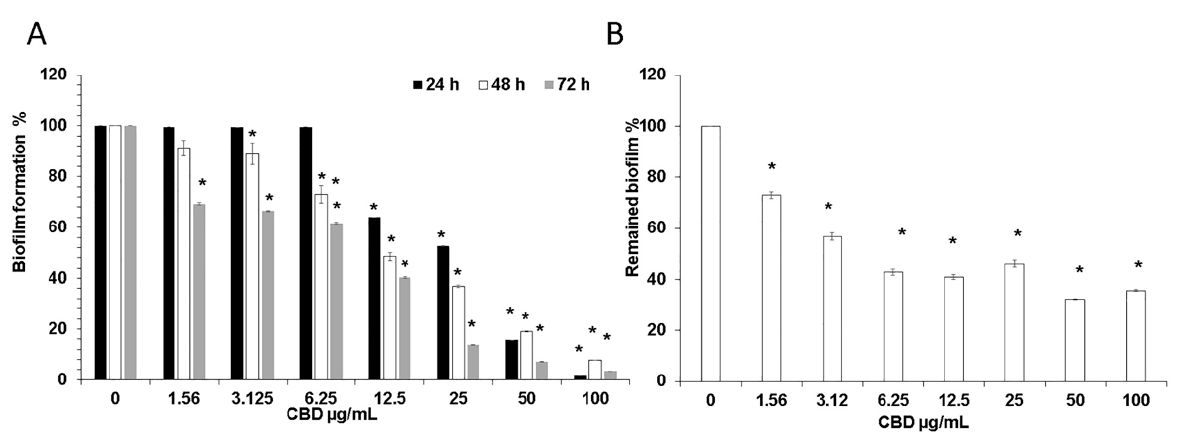
Figure 1. ( A ) Effect of CBD on C. albicans biofilm formation. C. albicans yeast cells were incubated with various concentrations of CBD for 24, 48, and 72 h at 37 ° C; ( B ) Effect of CBD on preformed biofilms. Biofilms of C. albicans which were 24 h-old were exposed for 24 h to various concentrations of CBD and the metabolic activity of biofilm cells was measured using the MTT assay. The values of the untreated control were set to 100%. * Significantly lower than the untreated control ( p < 0.05).